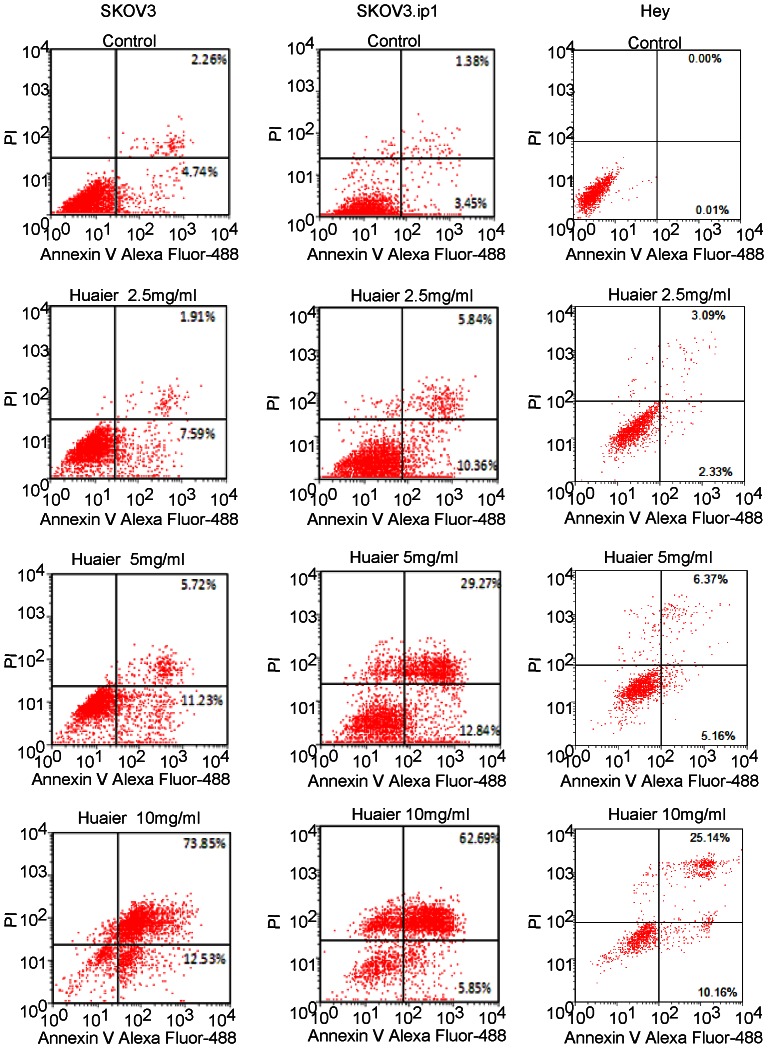
Huaier induces apoptosis in ovarian cancer cells in vitro.The percentage of apoptotic cells were measured by flow cytometry using the PI-annexin V assay. (A, B,C) Dot plots showing apoptosis in SKOV3 (A), SKOV3.ip1 (B) and Hey (C) cells with Huaier treatment at 0, 2.5, 5 and 10 mg/mL for 48 h.